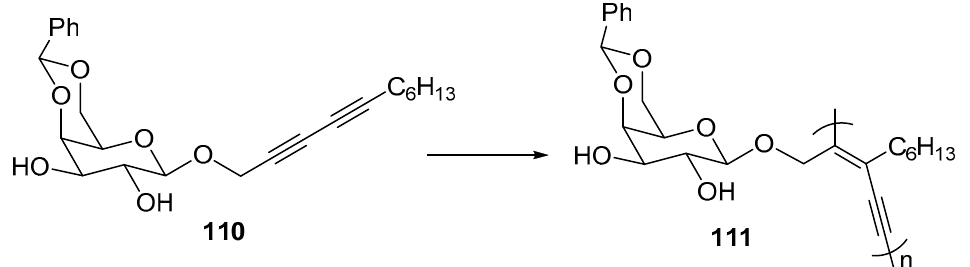
Figure 64. Diacetylene and glyco-polymer-based gelators [115], n represents the number of repeating units.